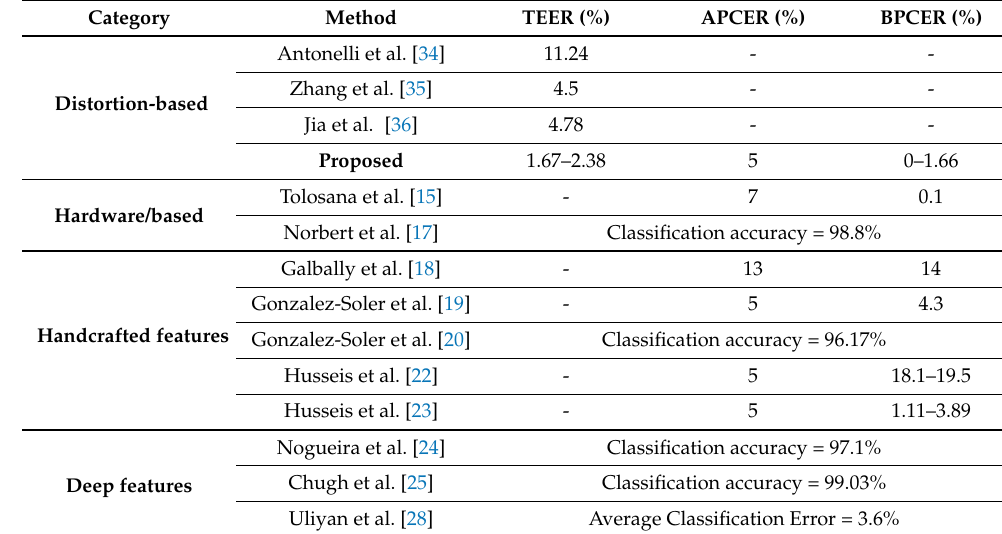
Table 10. Comparison with fingerprint-deformation-based PAD